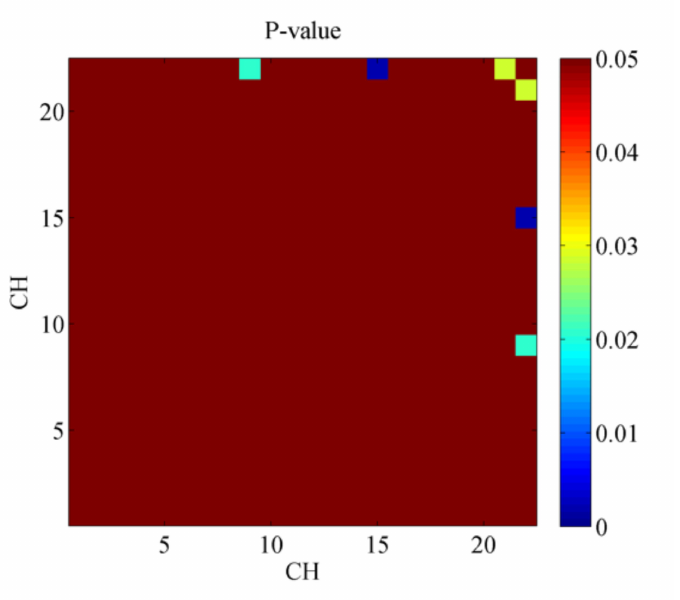
Figure 3. p -value of functional connectivity matrices for NUB and EUB ( p <